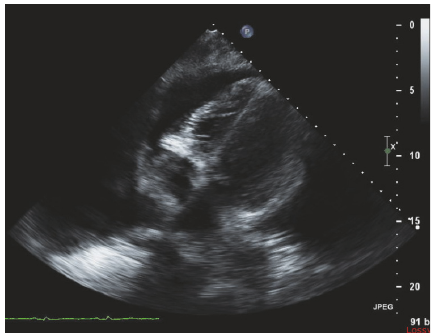
Figure 1: AP chest radiograph of the patient in the ED illustrating bilateral left greater than right chylous pleural effusions upon initial presentation.